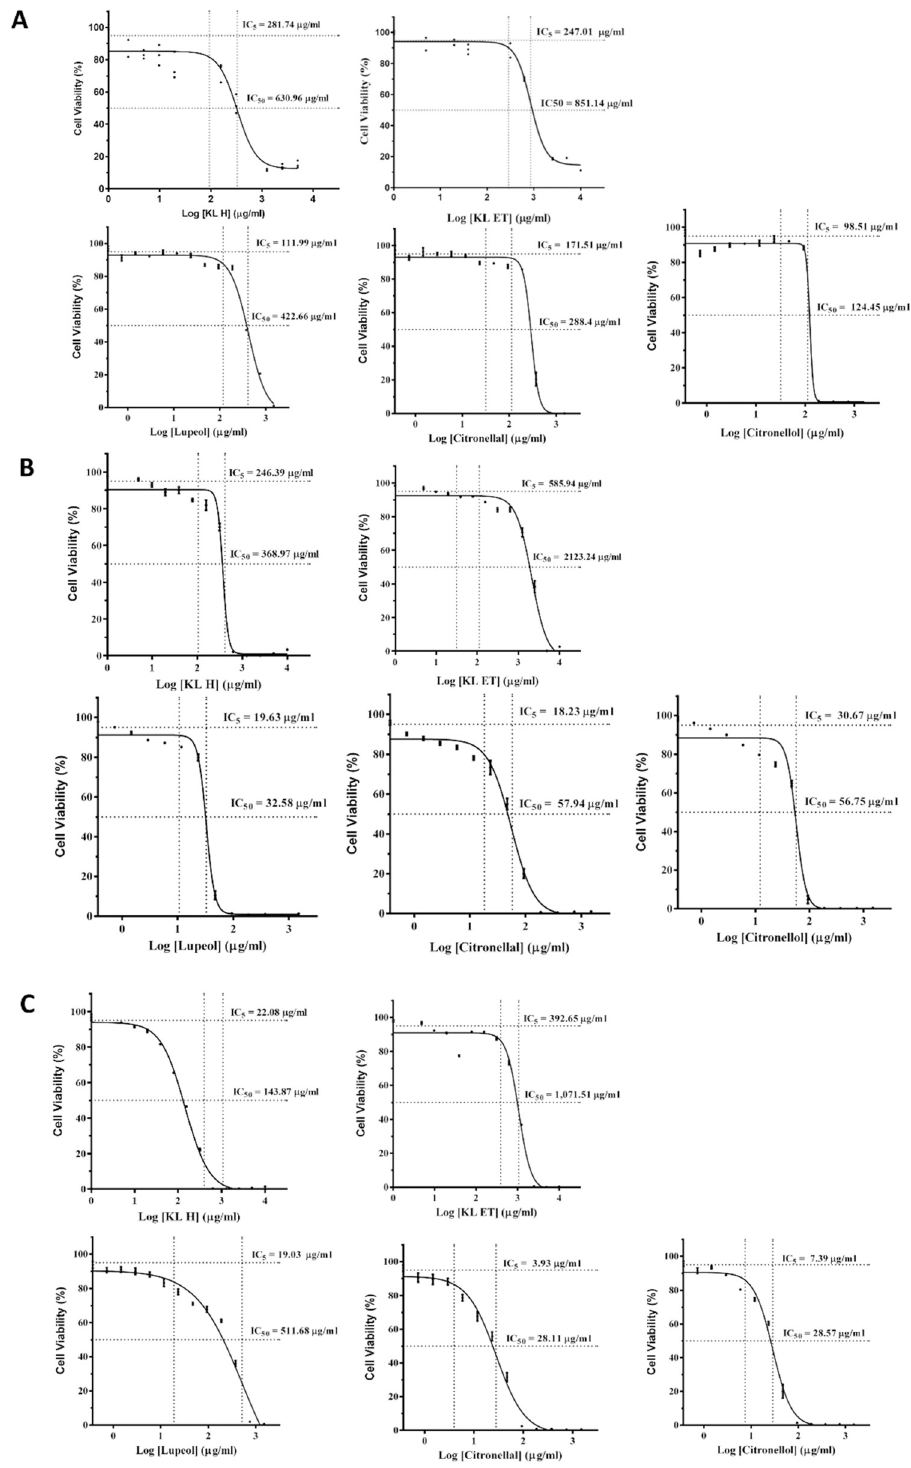
Fig 1. Investigation of the effect of KL H, KL ET, lupeol, citronellal and citronellal on cell viability of human monocyte-derived macrophages (MDM), THP-1 and SCC15 cell lines. MTT assays were performed after cell treatment for 24 hours. (A) IC5 and IC50 values of MDM after treatment under different concentrations of lupeol, citronellal and citronellal. (B) IC5 and IC50 values of extracts and compounds on THP-1. (C) IC5 and IC50 results for anti-proliferative effect of KL H, KL ET, lupeol, citronellal and citronellal on SCC15. KL H: Crude hexane; KL ET: Crude ethanolic extract.